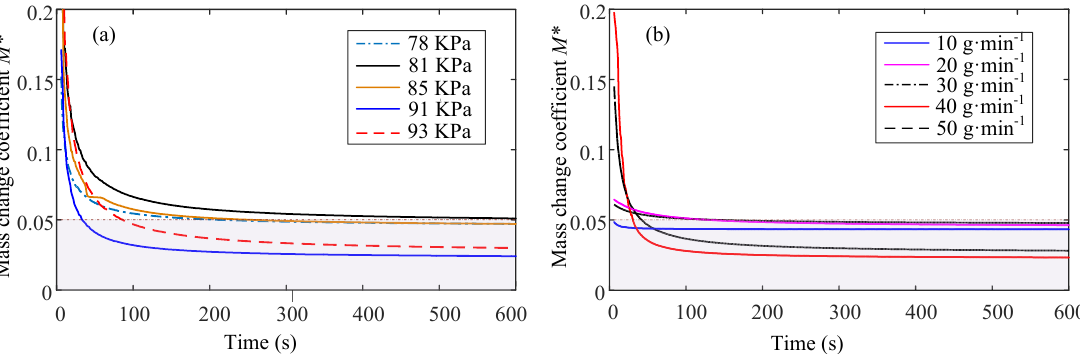
Figure 7. Influence of dynamic working conditions on the relative mass change coefficient M *: ( a ) pressure; ( b ) liquid flow rate.